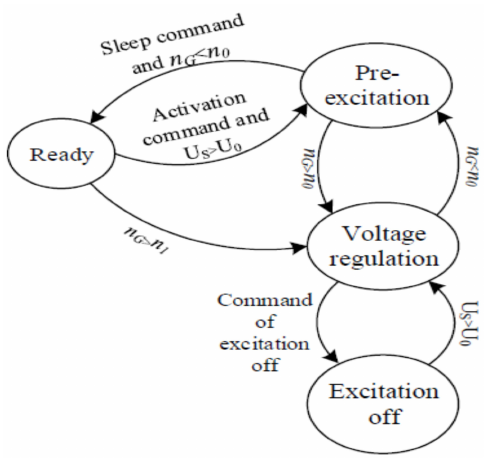
Figure 7. Modes of operation for the intelligent alternator [14].